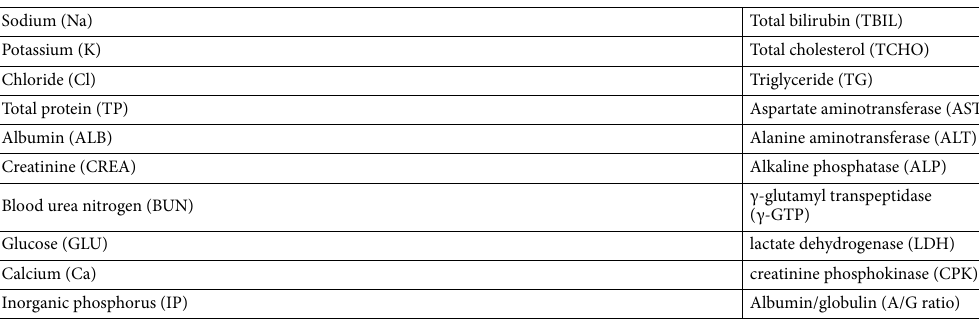
BALF of only male rats was analyzed 1 and 2 weeks after exposure. To obtain BALF, the upper end of the trachea was cut, and a polypropylene tube attached to a syringe was inserted; the trachea was then washed three times with 4 mL of phosphate-buffered saline (PBS). The collected BALF was centrifuged at 450 g for 10 min, and the supernatant was stored at − 80 °C. The cell pellet was re-suspended in fresh PBS, and the total immune cell count was determined by using a Hematology Analyzer (ADVIA 2120i). The re-suspended cell pellet was cen- trifuged at 270 g for 10 min using a Cytospin centrifuge (Cellspin; Hanil, Gimpo, Korea) and stained using Diff- Quick staining solution. Differential cell counts were determined using a light microscope at 100 × magnification. The supernatant separated from the BALF was thawed at ~ 20 °C just before cytokine analysis. A commercially available cytokine multi-magnetic bead array kit (R&D Systems, Minneapolis, MN 55413) was used to determine the concentrations of interleukin (IL)-1β, IL-6, IL-4, tumor necrosis factor alpha (TNF-α), and macrophage